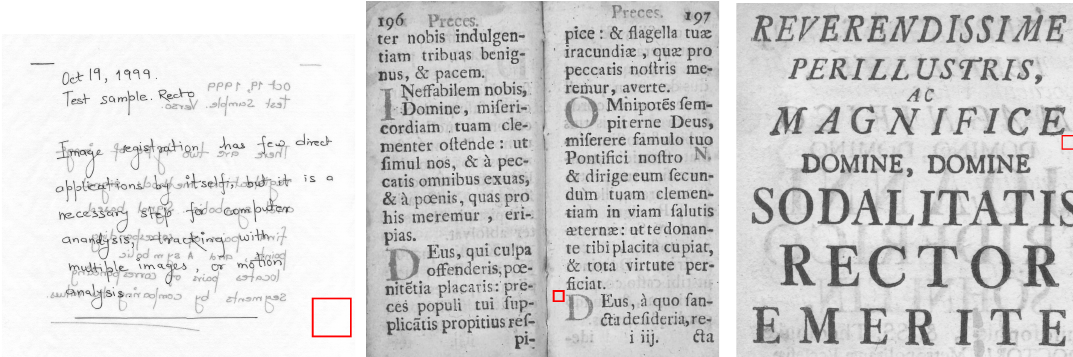
Figure 10. Background region detection for three different inputs. Red-colored squares are the regions located by our